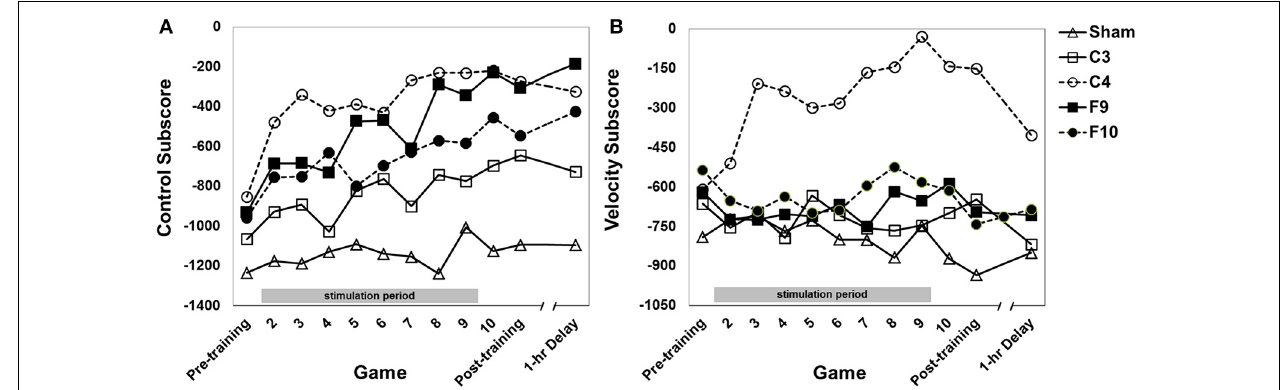
FIGURE 5 | (A) Control subscore for each stimulation group across 12 games with varying instructional emphasis. (B) Velocity subscore for each stimulation group across all 12 games with varying instructional emphasis. Pre-training, Post-training and 1-hr Delay games were all “total emphasis” games. The training block consisted of Games 2 through 10. Game 2 was “control score” emphasis, Game 3 was “velocity score” emphasis, Game 4